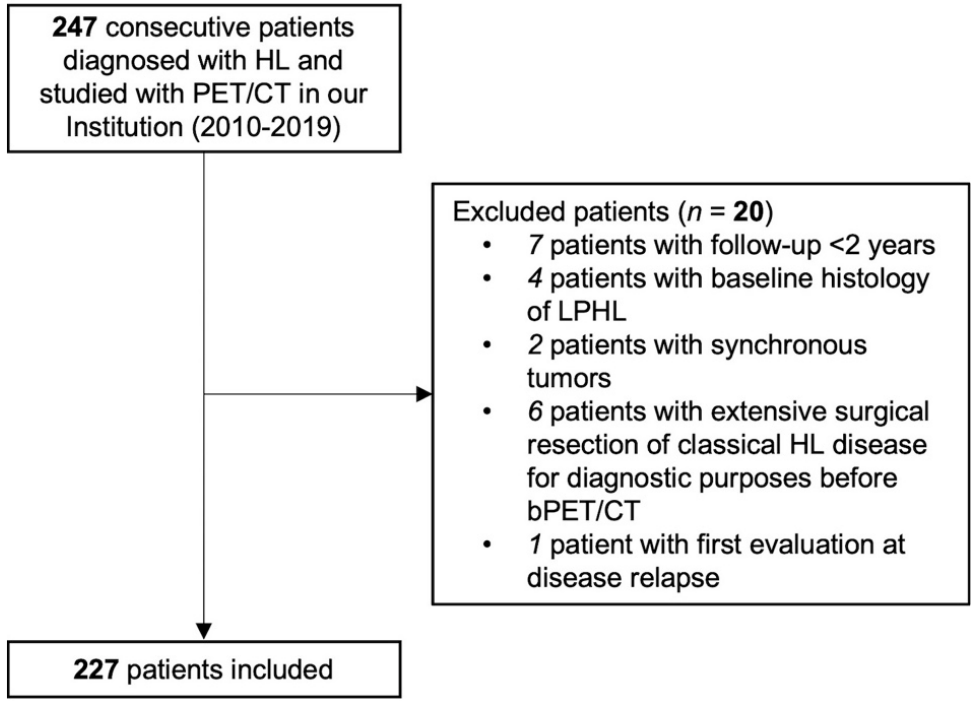
Figure 3. Flowchart of patients’ selection. HL, Hodgkin’s lymphoma; LPHL, nodular lymphocyte-predominant HL.